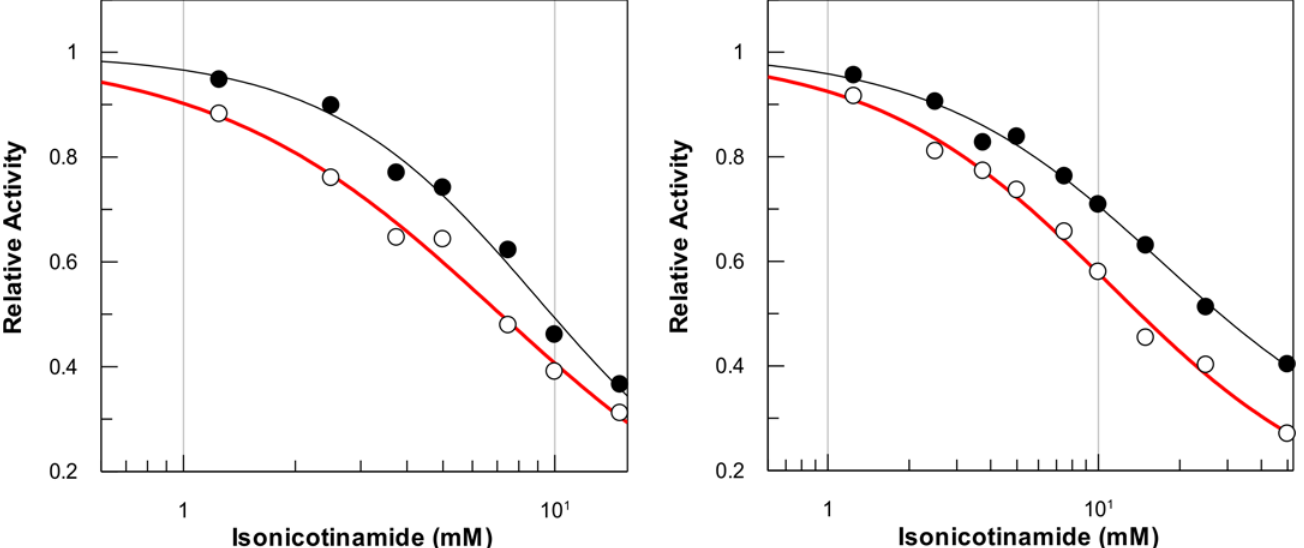
Fig 8. Effects of Isonicotinamide on SIRT1 and SIRT 5 Catalyzed reactions. (A) Dose-response of SIRT1 deacetylation activity in the presence of varying concentrations of isonicotinamide (from 0 to 15 mM) and NAD + (50 μ M and 5 mM). The solid smooth lines represent the best fit of the data for the IC 50 values as 7.0 ± 2.9 mM (in the presence of 50 μ M NAD + ) and 8.9 ± 3.3 mM (in the presence of 5 mM NAD + ), respectively. (B) Dose-response of SIRT5 desuccinylation activity in the presence of varying concentrations of isonicotinamide (from 0 to 15 mM) and NAD + (50 μ M and 5 mM). The solid smooth lines represent the best fit of the data for the IC 50 values as 11.1 ± 2.2 mM (in the presence of 50 μ M NAD + ) and 17.1 ± 4.0 mM (in the presence of 5 mM NAD + ), respectively.